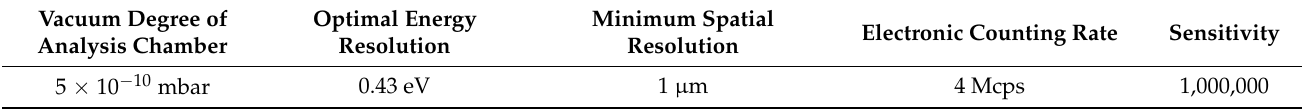
Table 1. Main technical specifications of X-ray photoelectron